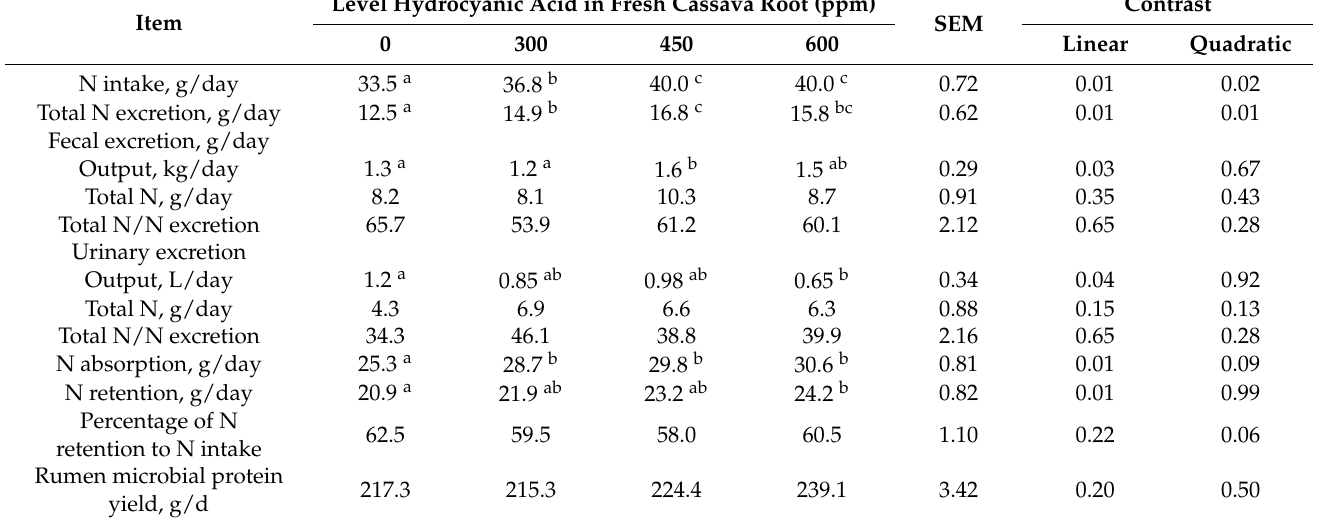
Table 5. Effects of different levels of fresh cassava root on feed intake and N utilization of Thai native beef